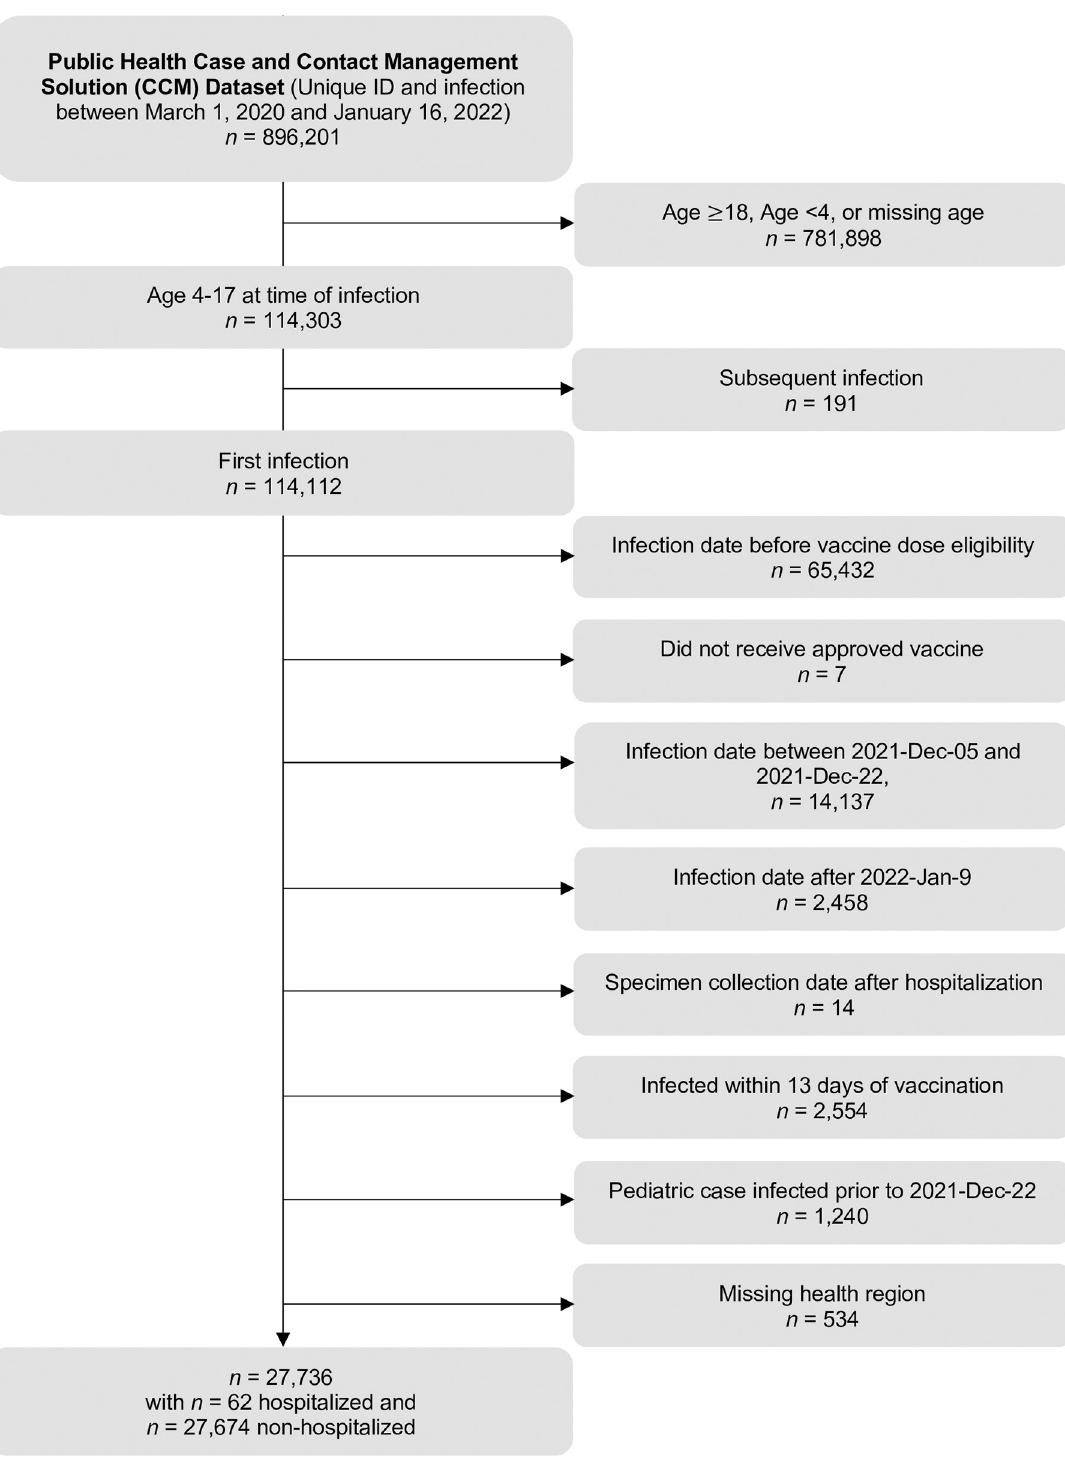
Fig 1. Flow diagram for creation of